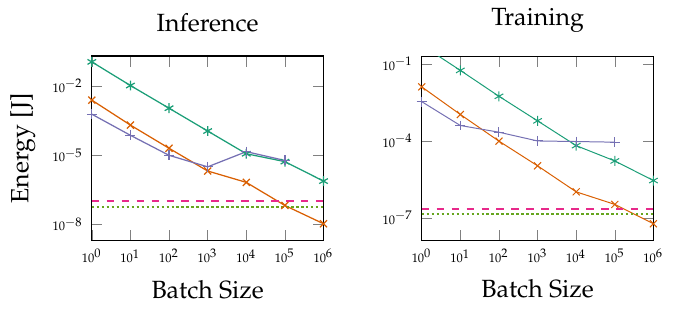
Figure 14. Power comparison.